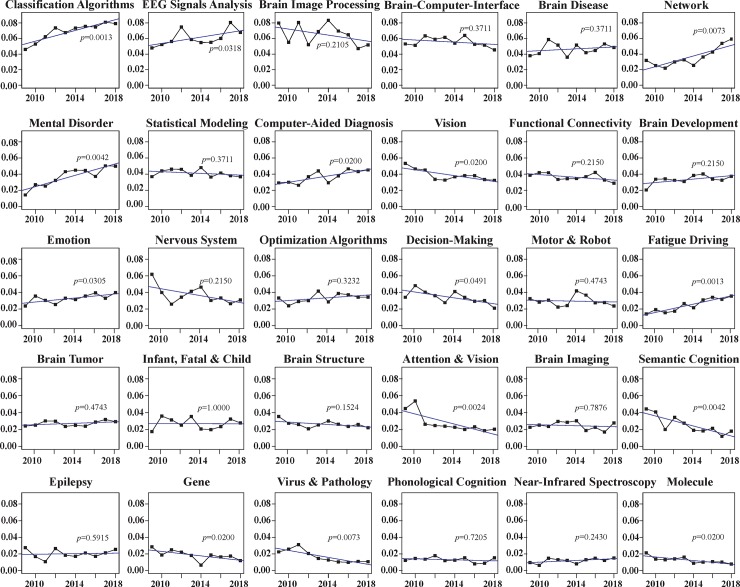
Annual trends of the identified topics (2009–2018).